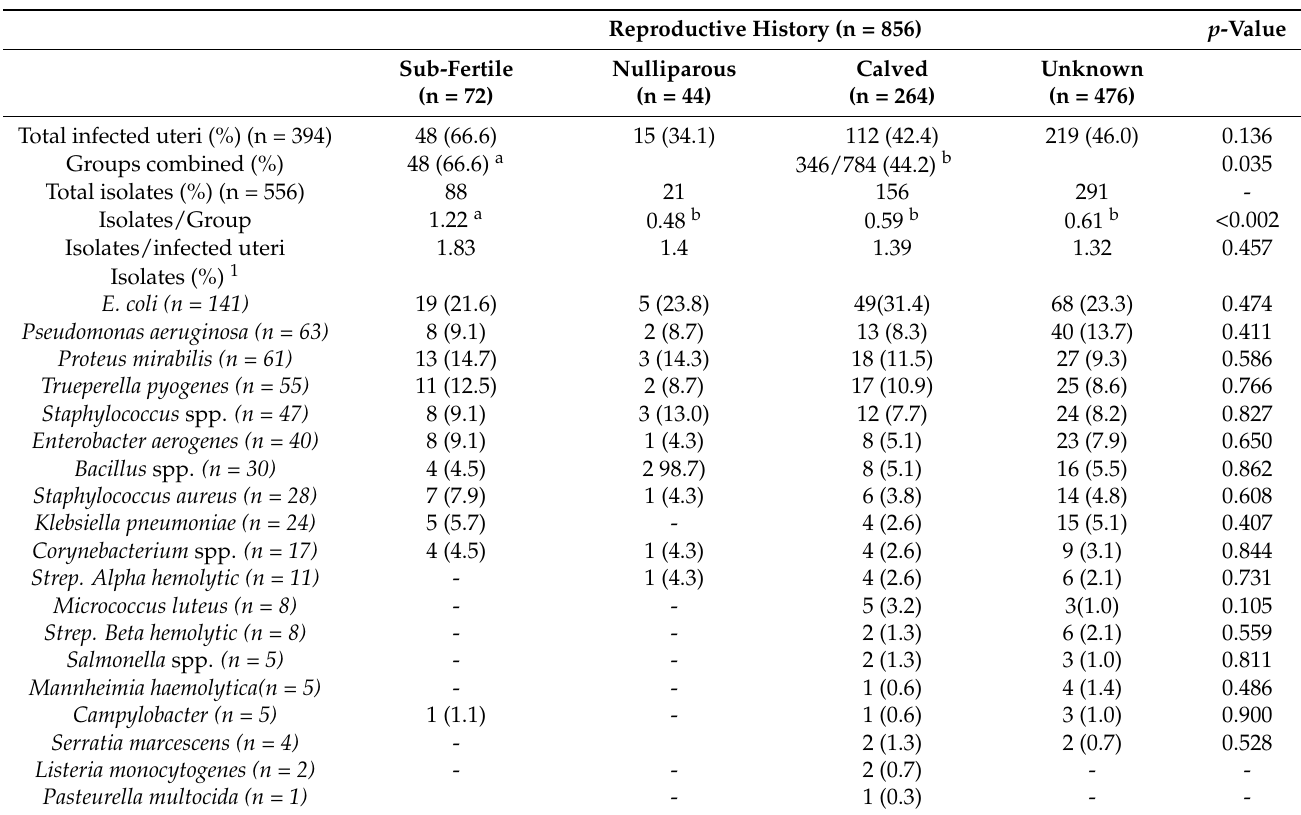
Table 2. Uterine bacterial isolates from camels with different reproductive